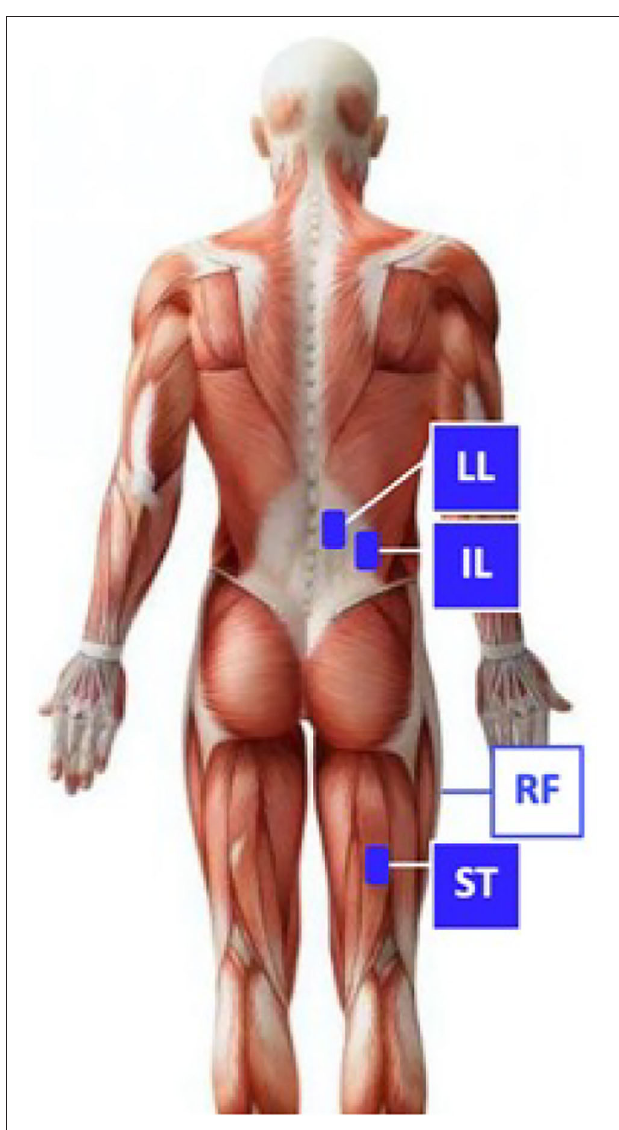
FIGURE 2 | Schematic representation of electrodes placement. For greater clarity, only the right side electrodes are displayed for the back. It is possible to identify the Erector Spinae Longissimus Lumborum (LL), the Erector Spinae Iliocostalis (IL), the rectus femoris, and the semitendinosus.